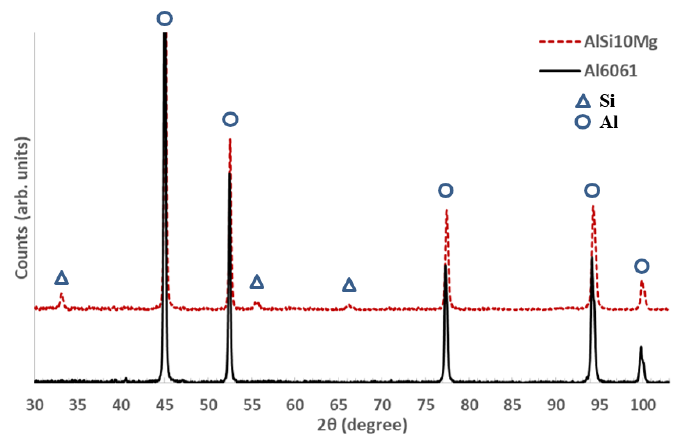
Figure 2. Particle size distribution of the Al6061 and AlSi10Mg powders.